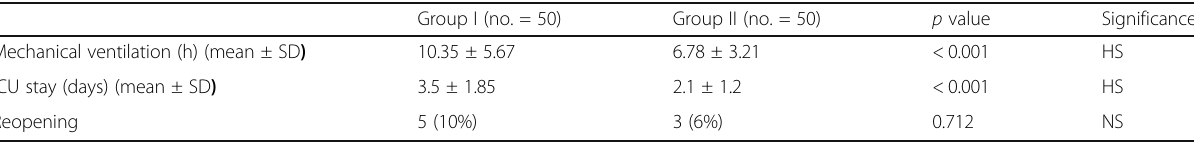
Table 5 Postoperative data